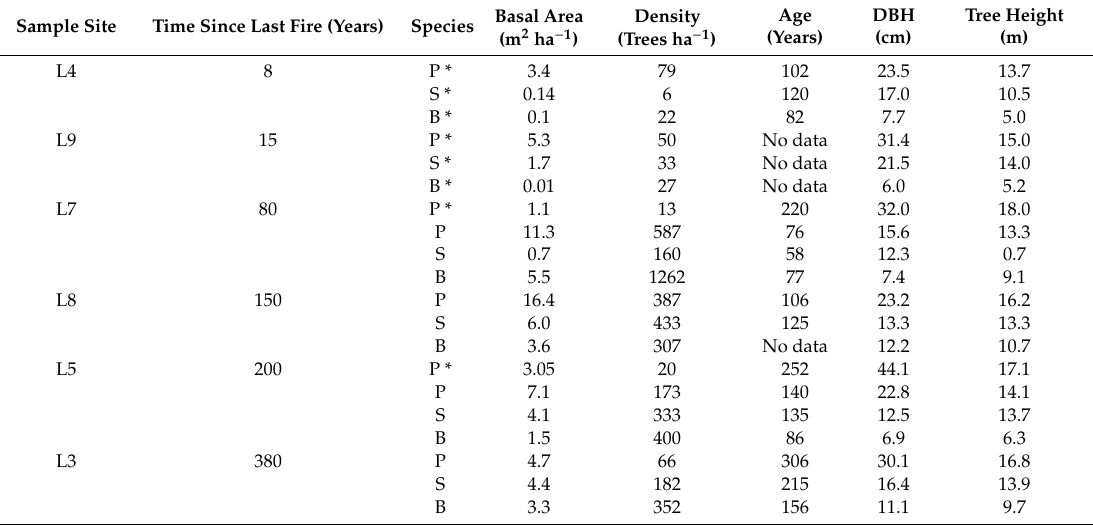
Table 1. Forest stands (diameter at breast height (DBH) > 4 cm) data from the investigated simple plots. Sample